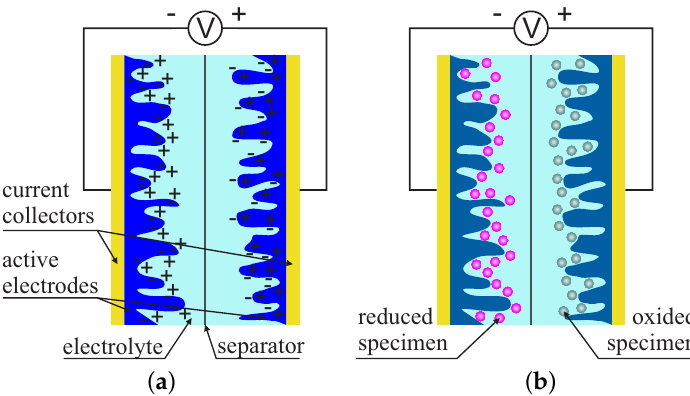
Figure 2. A schematic illustration of supercapacitors: an electrical double-layer capacitor ( a ); and a pseudocapacitor ( b ).